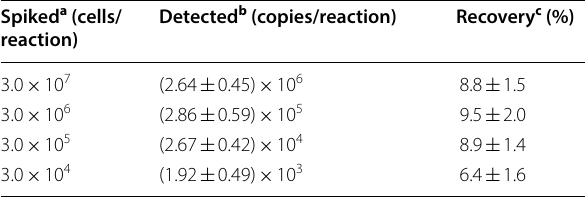
a Three 200 mg colonic digesta samples were spiked with 3 of SK9K4 T , giving spiked concentrations at 3